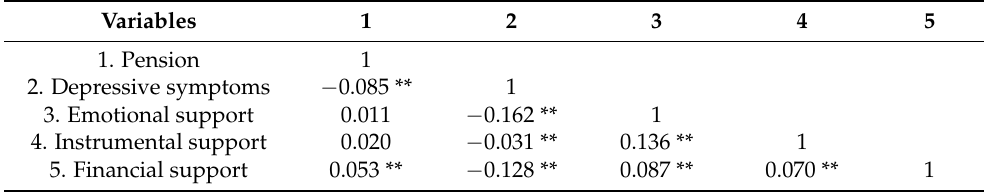
Table 2. Correlations among key variables ( N =